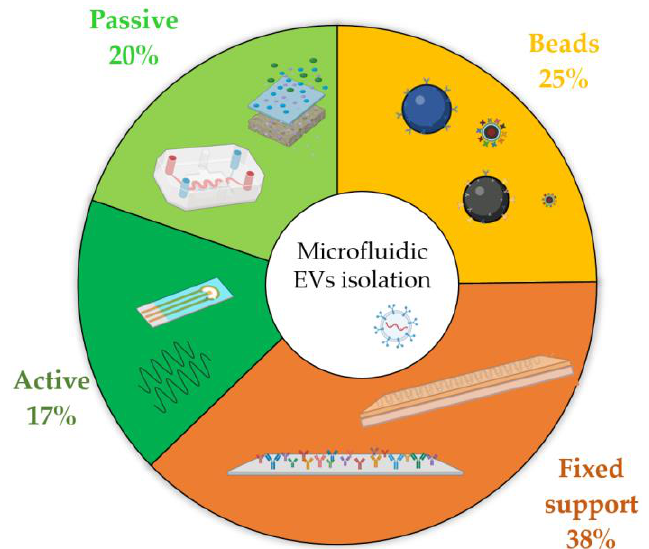
Figure 7. Frequency of the published works from 2000 to present (source: Web of Science database, excluding reviews, meeting abstracts, and retracted papers) related to each of the different isolation techniques that exploit microfluidic devices. Physical approaches are subdivided into active (dark green) and passive (green), whereas chemical immunocapture is separated by fixed supports (orange) and floating beads (yellow).